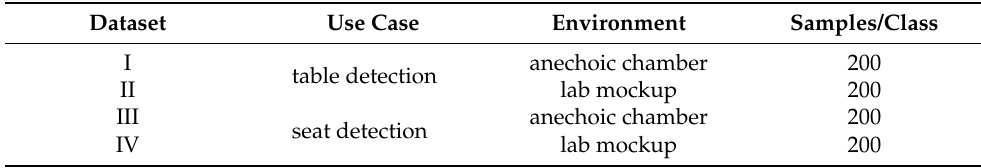
Table 1. Surveyed CIR datasets for different use cases and